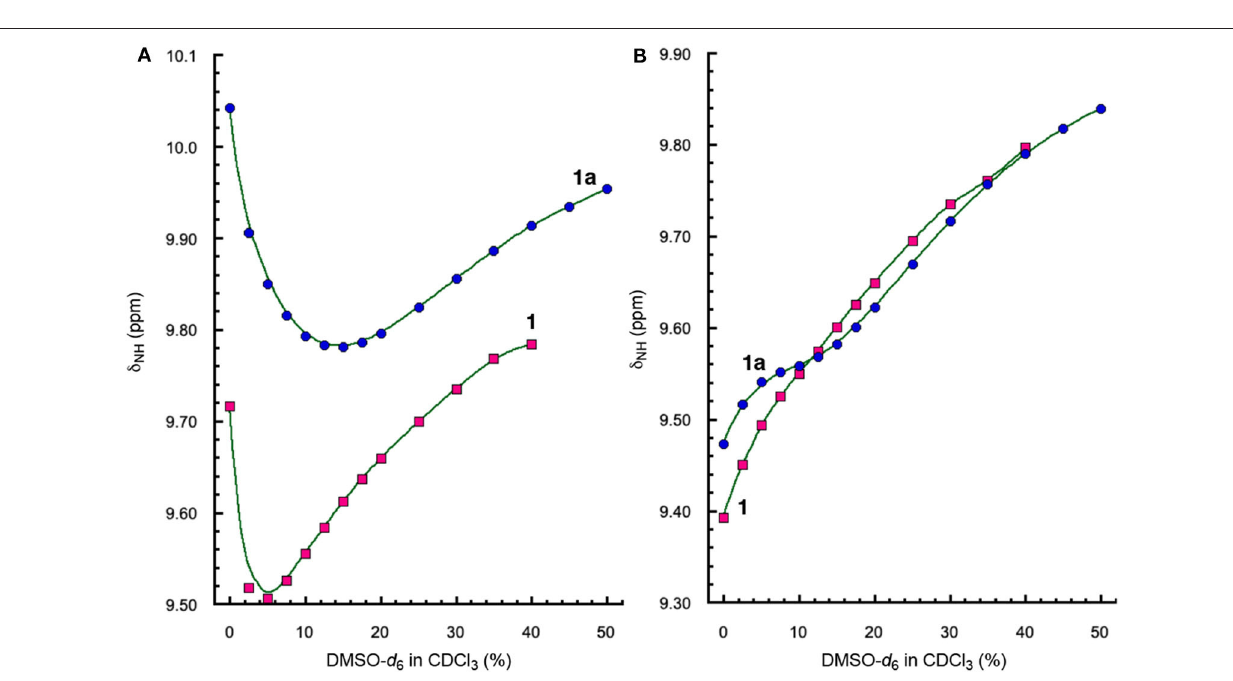
FIGURE 4 | Plots of chemical shifts ( δ NH ) of amide protons (A) a and (B) d , of 1 (5mM) and 1a (5mM) versus percent of DMSO- d 6 in CDCl 3